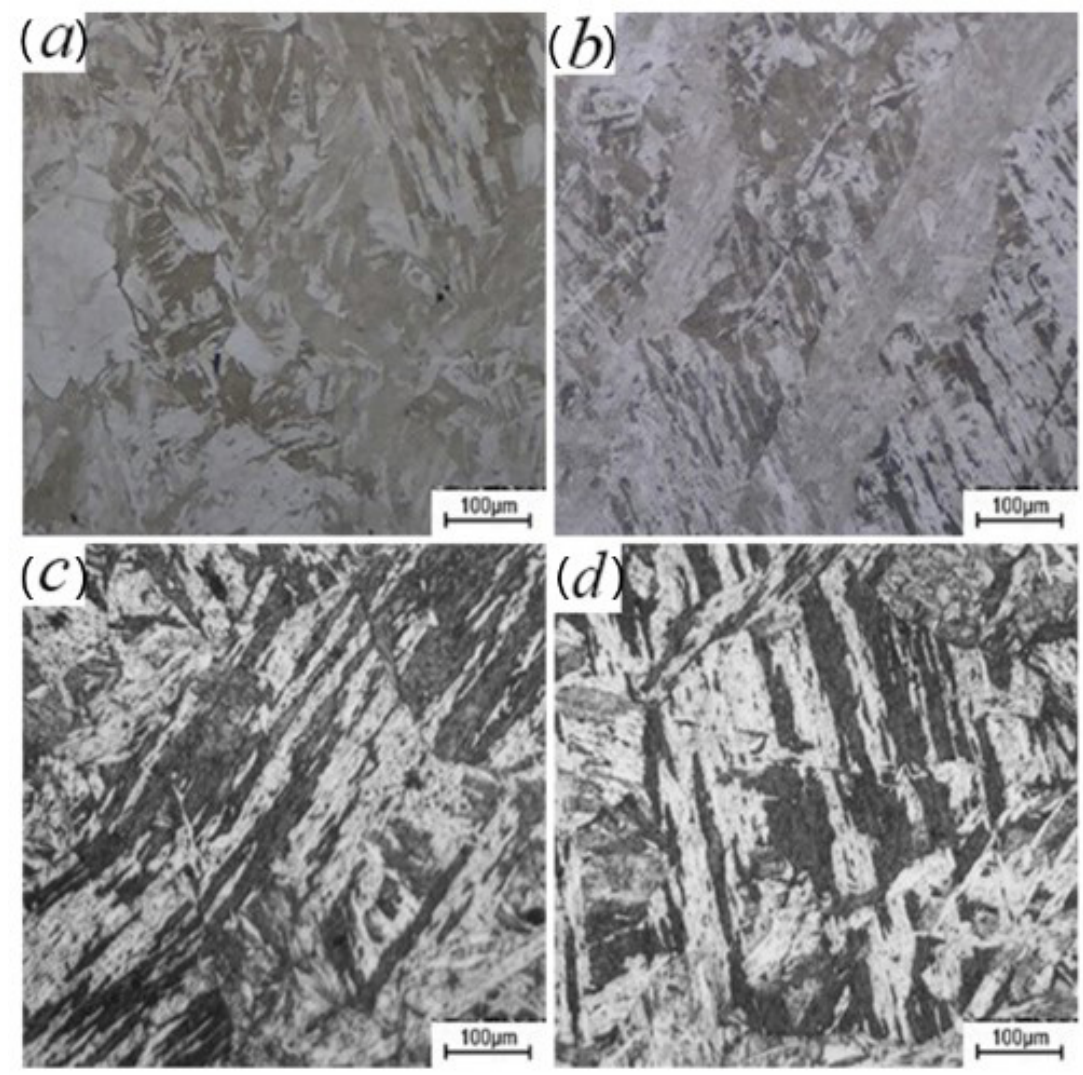
Figure 3. Microstructure in coarse grain heat affected zone (CGHAZ) under different holding time: (a) unannealed, (b) 760°C+4h, (c) 760°C+5h, and